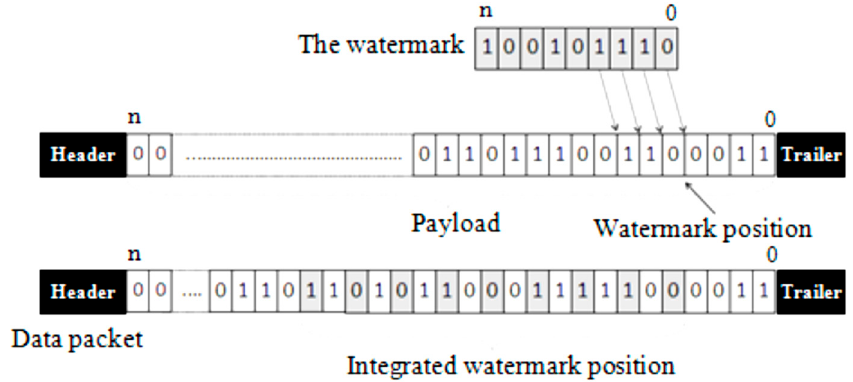
Figure 9. The watermark integration process.